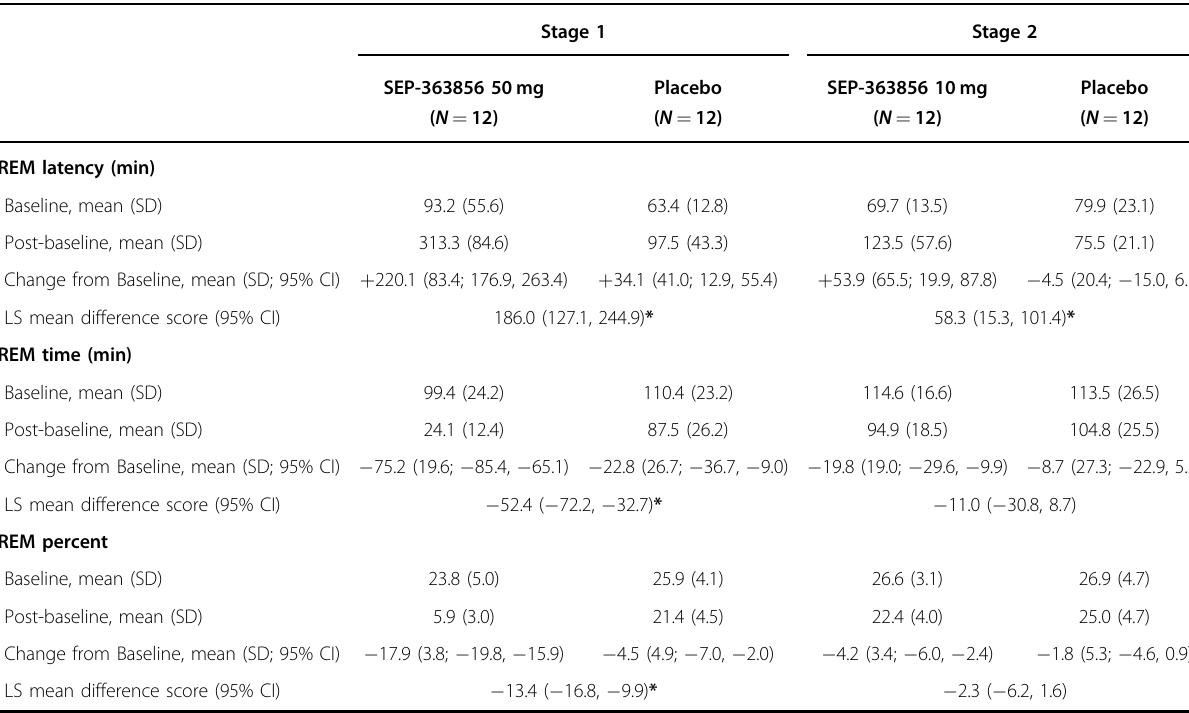
Table 2 REM sleep parameters in healthy males ( N = 12 per dose cohort) during crossover treatment with SEP-363856 (10 mg or 50 mg) vs.